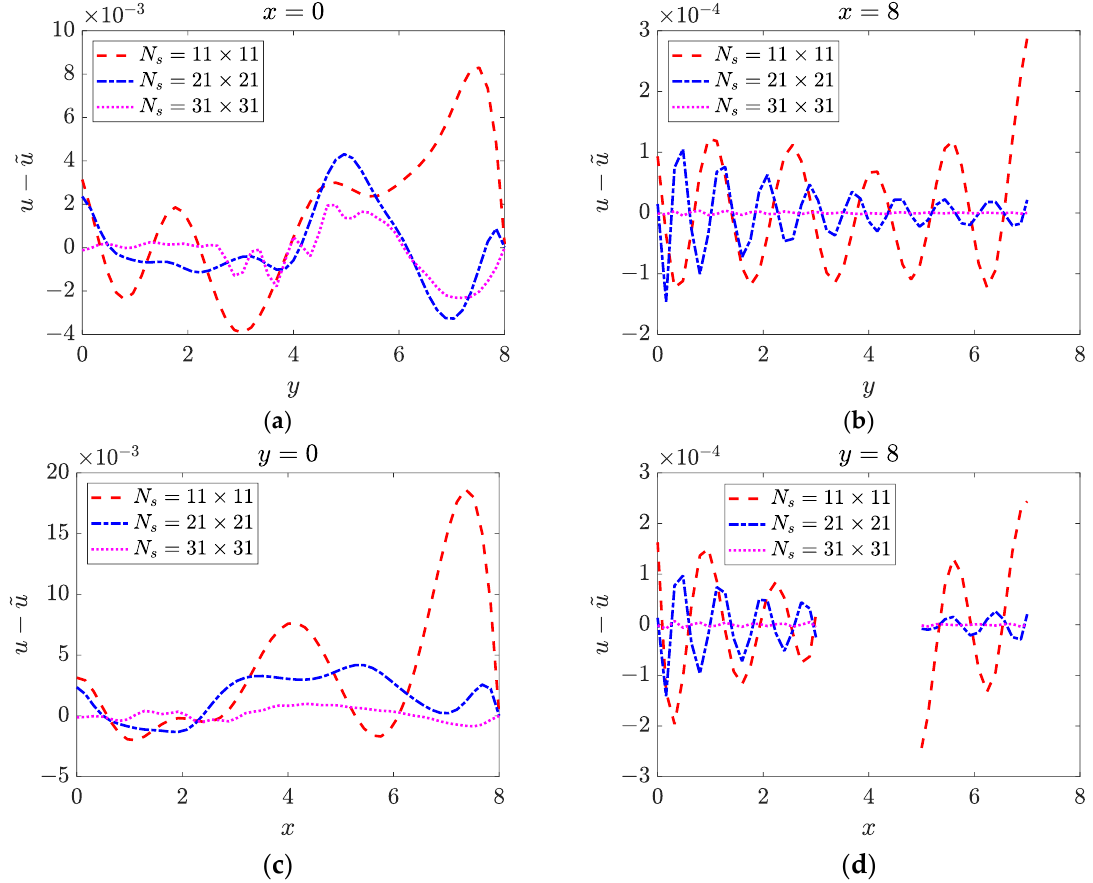
Figure 10. Boundary solutions for the 2D constant parameter identification problem in irregular geometry: ( a ) x = 0; ( b ) x = 8; ( c ) y = 0; ( d ) y =